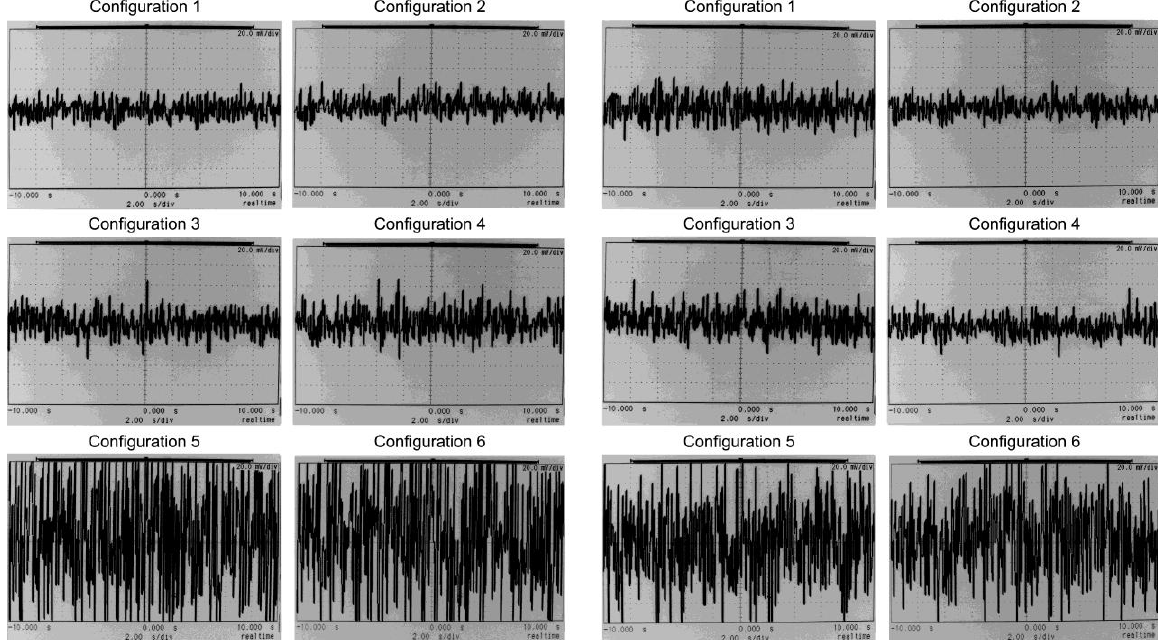
Figure 9. Noise graphs for the test circuit in Figure 5 at v op-amps. On the left, configurations 1–6 for the HPF in Figure 4. On the right, configurations 1–6 for the HPF in Figure 3. Vertical span is 160 mV (20 mV/div). Horizontal span is 20 s.